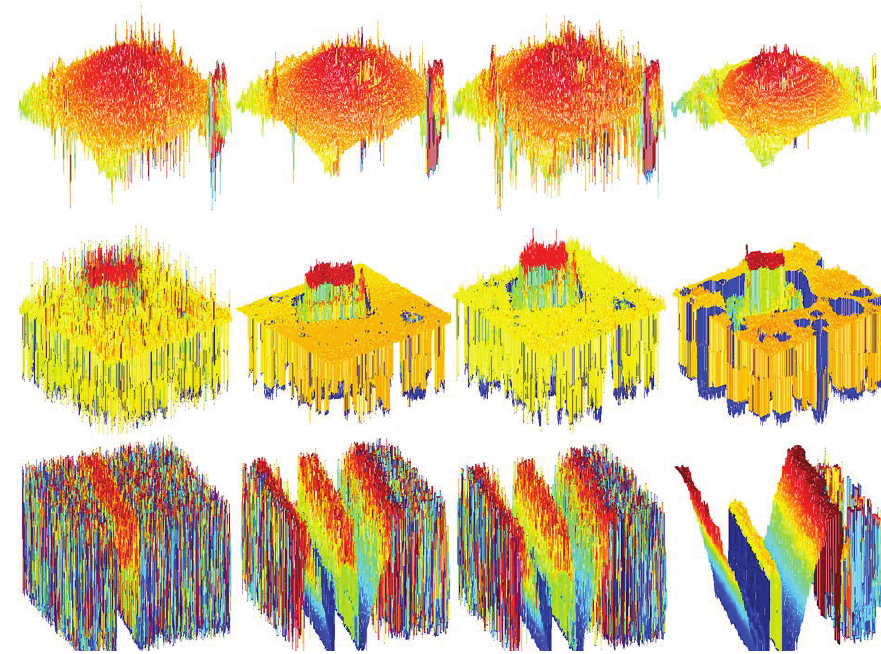
Figure 12. Depth maps: real cone (first row), micro sheet (second row), groove (bottom), ML (first column), GLV (second column), TEN (third column) and the proposed method (last column).